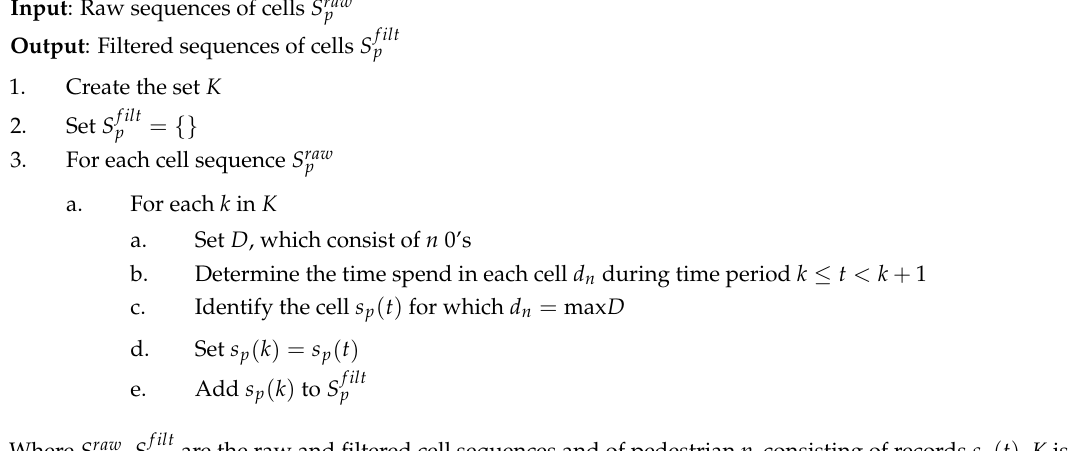
Algorithm 4: Description of the longest cell duration algorithm, which translates the raw cell sequence to a cell sequence of cells that was visited the longest during each time